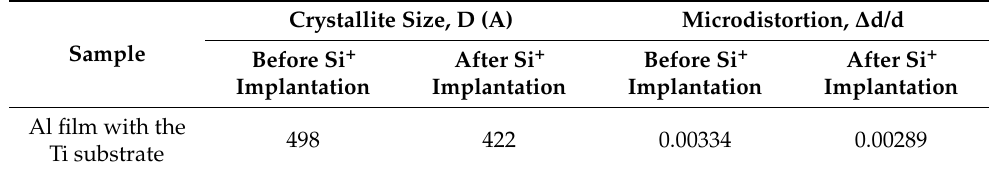
Table 3. Results of X-ray structural analysis after annealing at 700 ° С along the AlTi (111) plane.